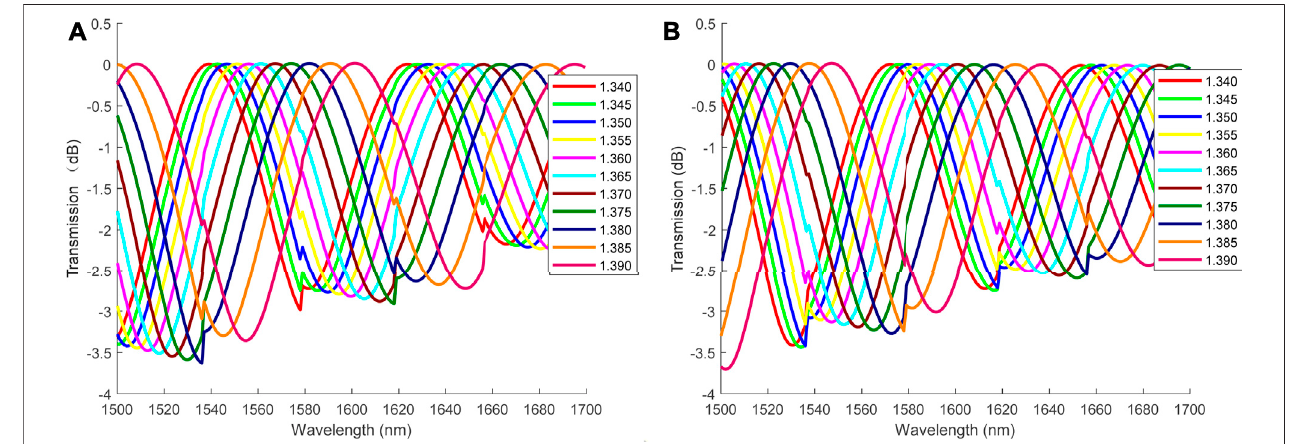
FIGURE 10 | Transmission spectrum of L variation when D 2 (cid:2) 20 μ m: (A) 6.55 mm; (B) 6.75 mm.